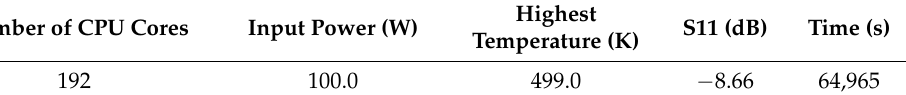
Figure 9. Calculated results of the antenna array and radome: ( a ) geometrical view, ( b ) electric field with dimensions of V/m, ( c ) temperature field with dimensions of K, and ( d ) strain field with dimensions of m.